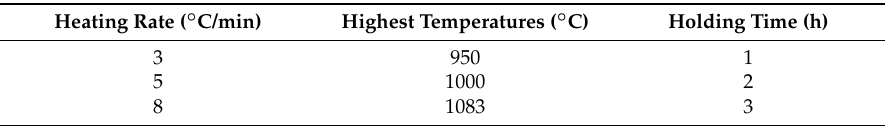
Table 3. The evaluated parameters of the sintering